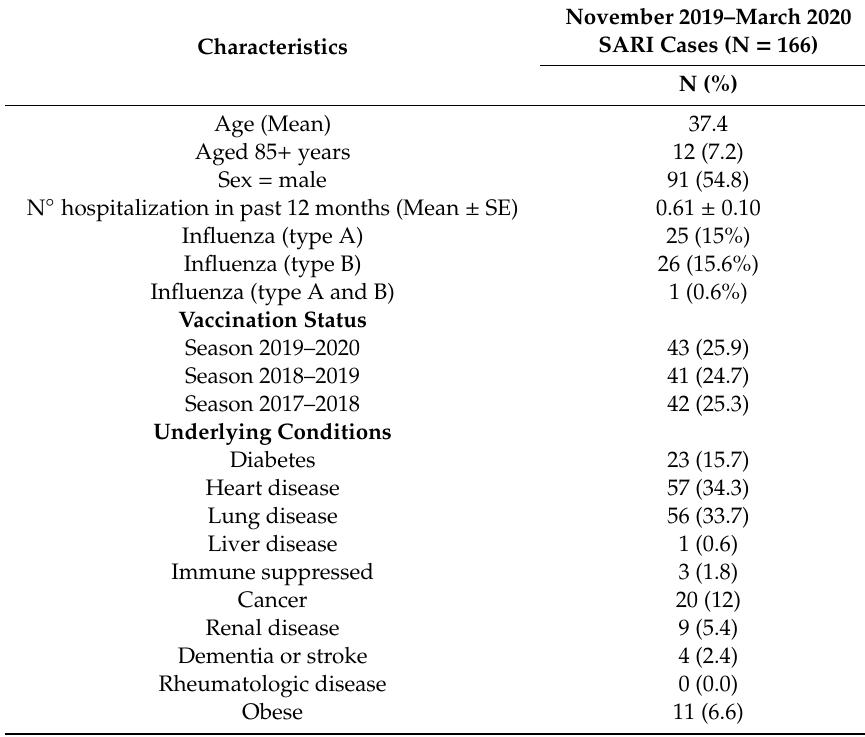
Table 1. Characteristics of the enrolled